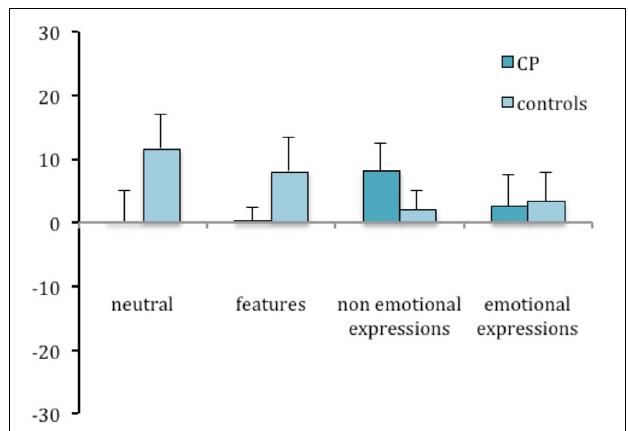
FIGURE 4 | Mean difference between upright and inverted conditions in the percentages of correct responses in the recognition task (task 1) plotted as a function of group and experimental manipulations. Error bars represent standard error of the mean.